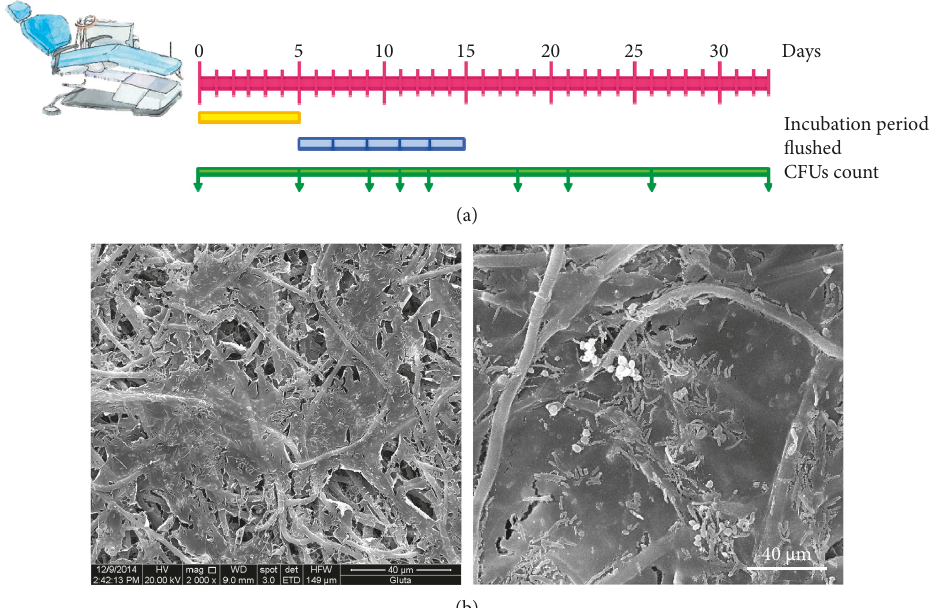
Figure 1: Scheme of the experimental time line (a). Incubation period: DUWLs were incubated with different solutions for 5 days (yellow bar). Flushed: DUWLs were flushed, every other day, with 1.6L water (blue bar). Flushing water was collected to measure the dispersed biofilms by OD. CFU count: Time point at which water samples were collected for bacterial CFU counts (green bar with arrow). SEM image of biofilm mass on the inner surface of DUWLs (b). Magnification × 2000 (left image); A higher magnification image is shown on the right